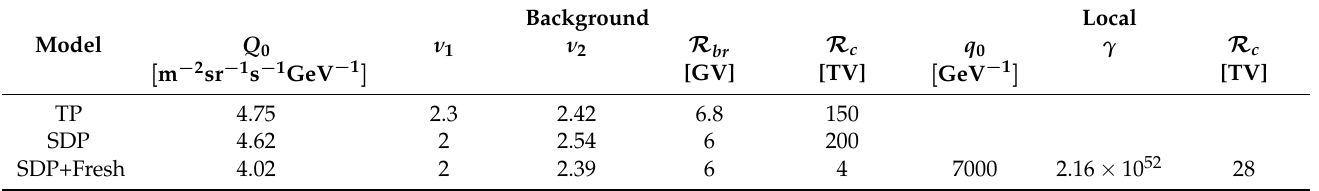
Table 2. The Background and Local SNRs-Injected Parameters for